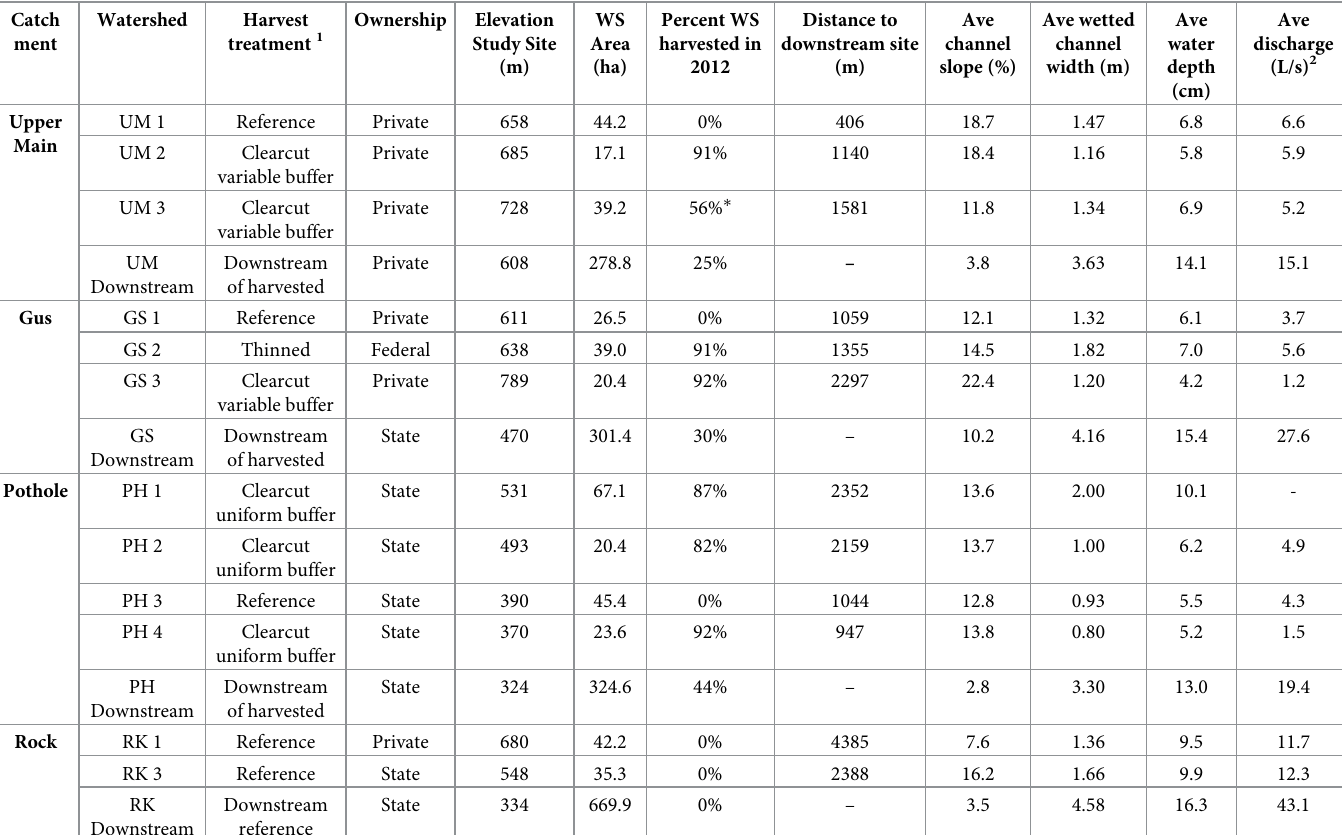
Table 1. Study site